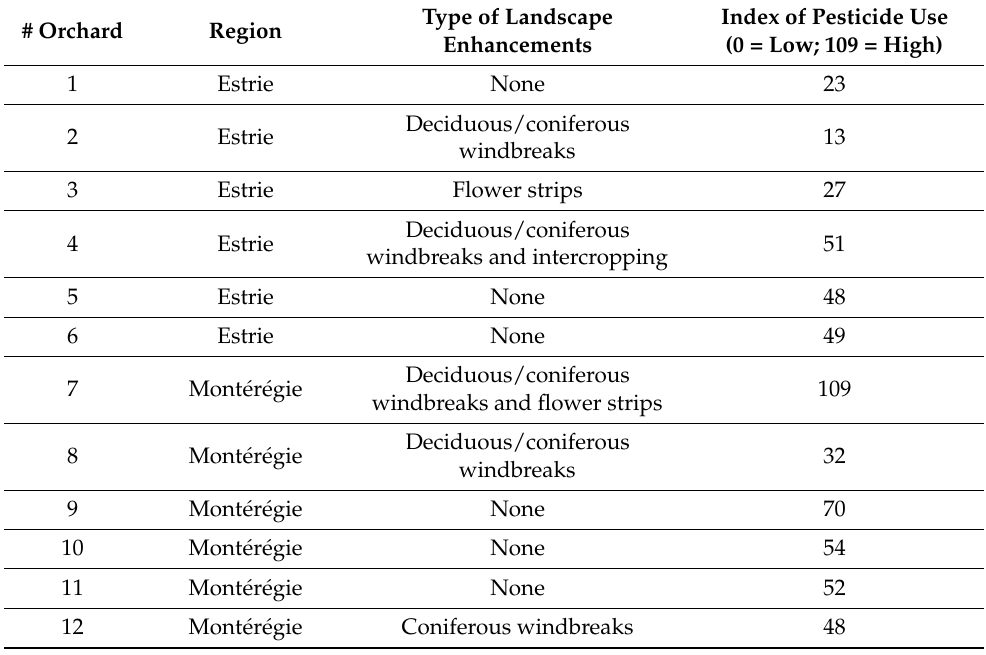
Table 1. Characteristics of the 12 orchards sampled from 2017 to 2019. The orchard numbers correspond to those in Figure 1. Intensity of pesticide use was defined according to Equation (1) (see